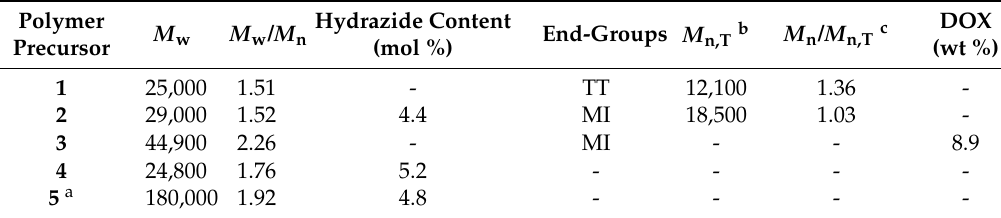
Table 1. Characteristics of polymer